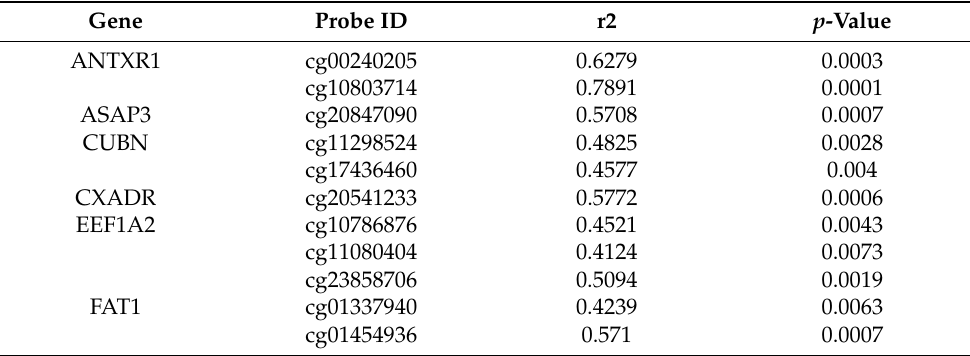
Table 2. Infinium probes with high DNA methylation/transcript level correlation among arterial- venous